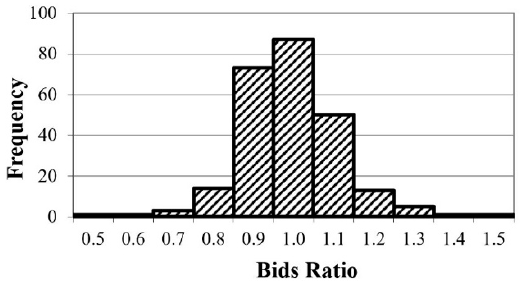
Figure 5. Bid distribution.